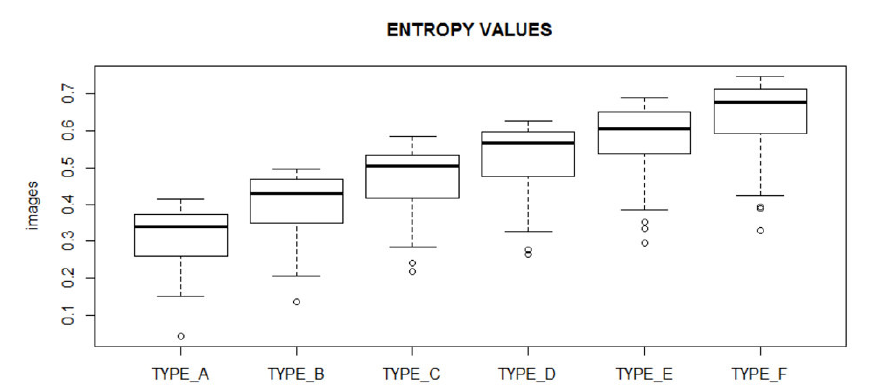
Figure 4. Change in entropy with increased noise